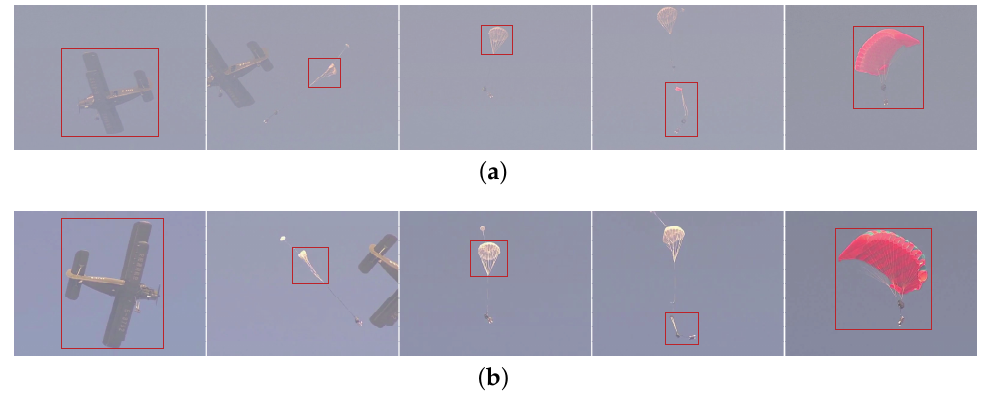
Figure 13. Target tracking switch. ( a ) The tracking switch when the aircraft enters the camera field, from right to left; ( b ) The tracking switch when the aircraft enters the camera field, from left to right.